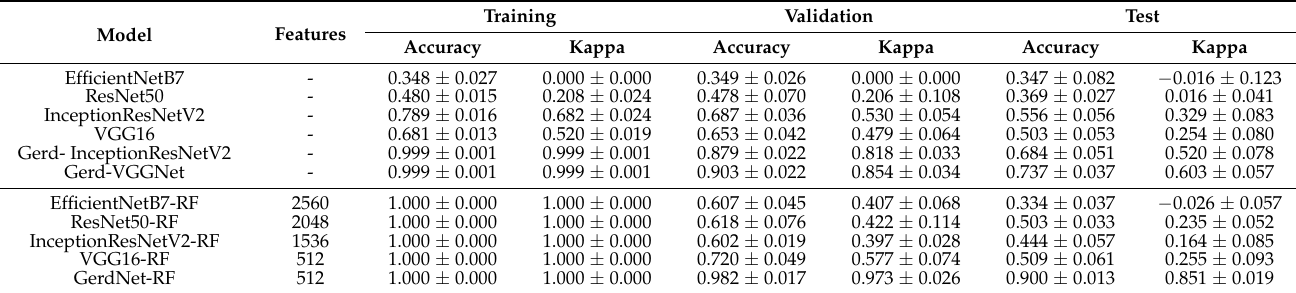
Table 1. Performance evaluation of five feature